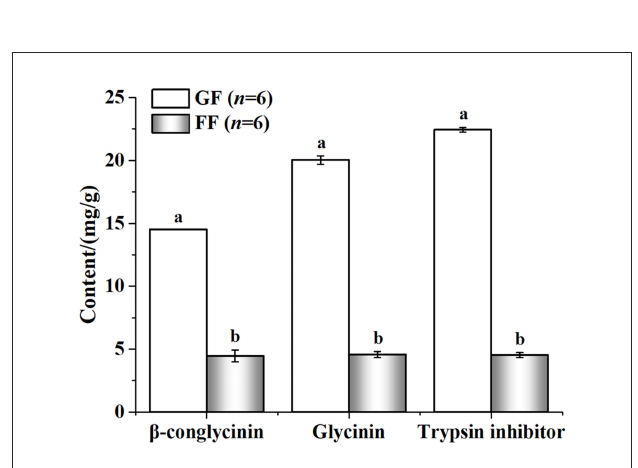
FIGURE4 Effect of fermentation on the concentration of anti-nutritional factors.